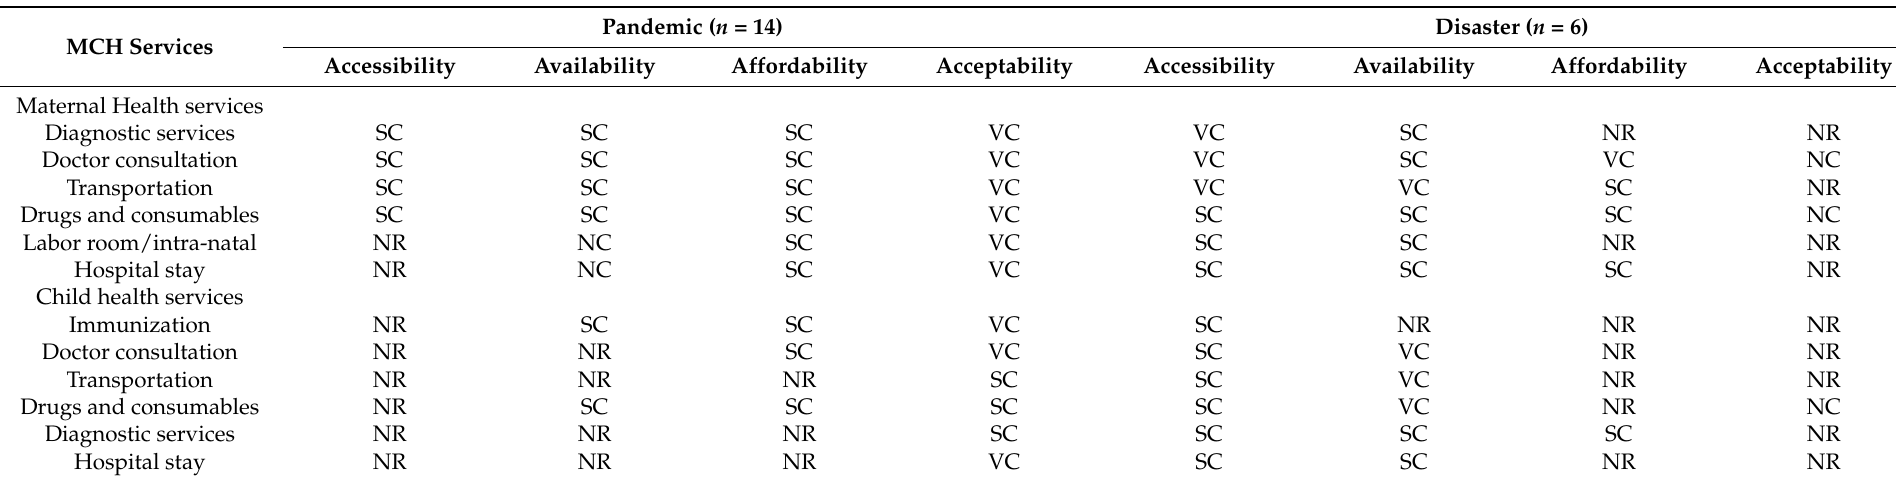
Table 3. Magnitude of the perceived challenges for maternal and child health services during pandemic or